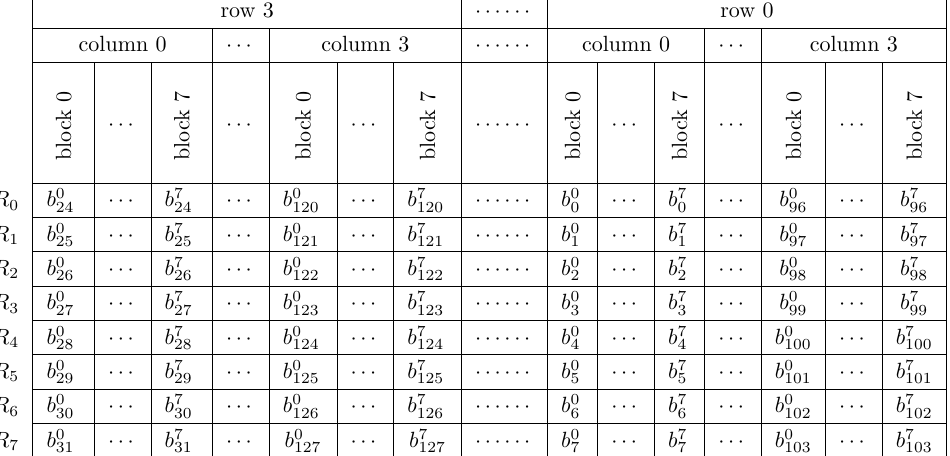
Figure 3: Bitsliced representation from [KS09] using 8 128-bit registers R 0 , · · · , R 7 to process 8 blocks b 0 , · · · , b 7 in parallel where b i